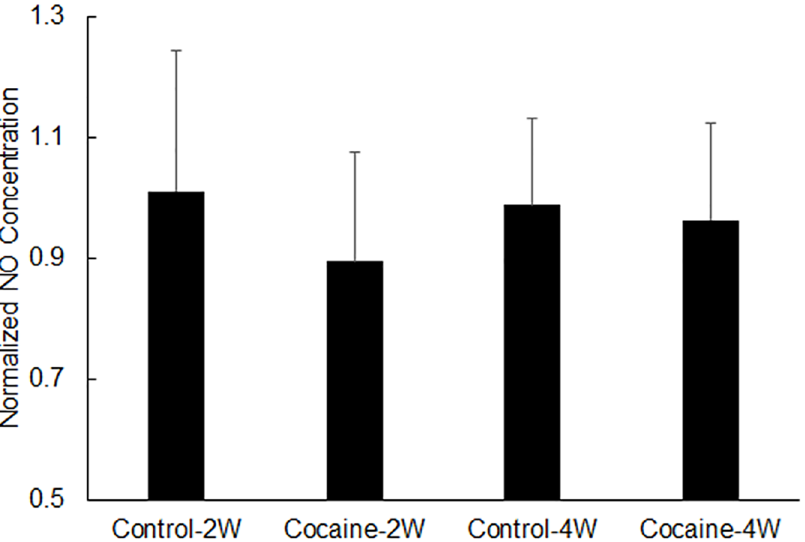
Fig 1. Normalized plasma NO concentration in control rats and cocaine-treated rats. “2W” stands for “2 weeks”, and “4W” stands for “4 weeks”. All data was normalizedto the averageplasma NO concentration of 2-week control rats. Data is presented as mean + standarderror (n = 4–9).